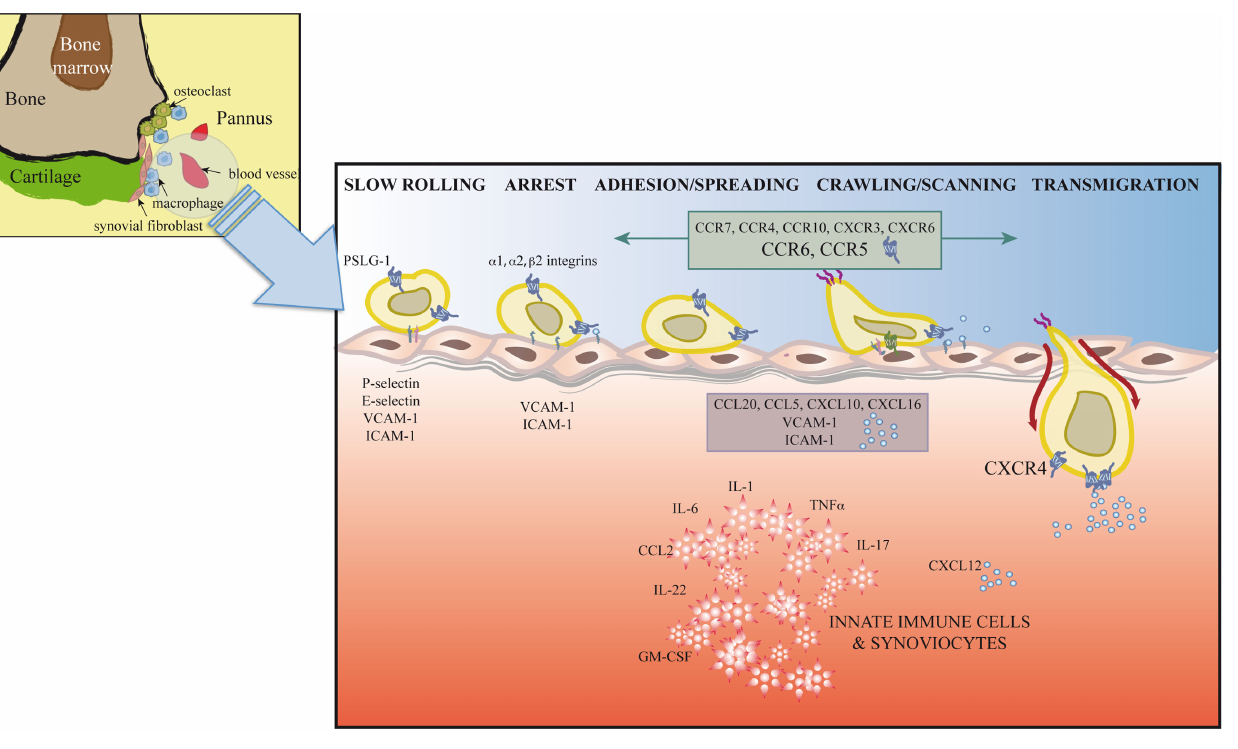
FIGURE 2 | Extravasation model for T cells at the inflamed joint . In response to proinflammatory mediators, leukocytes and vascular cells are activated. Among other immune cells, T cells (Th1, Th17, Treg, and possibly Th22) initiate a serial cascade (rolling, arrest, spreading, crawling, and